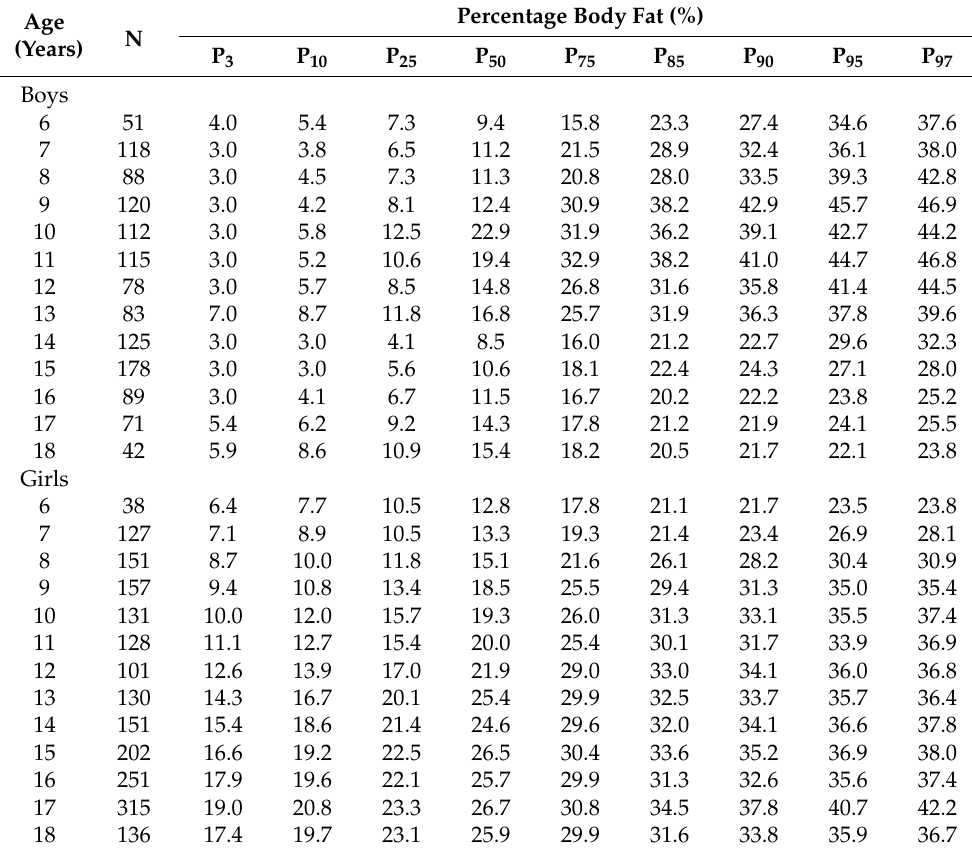
Table 3. Percentage body fat in percentiles according to age and sex in the boys and girls in this